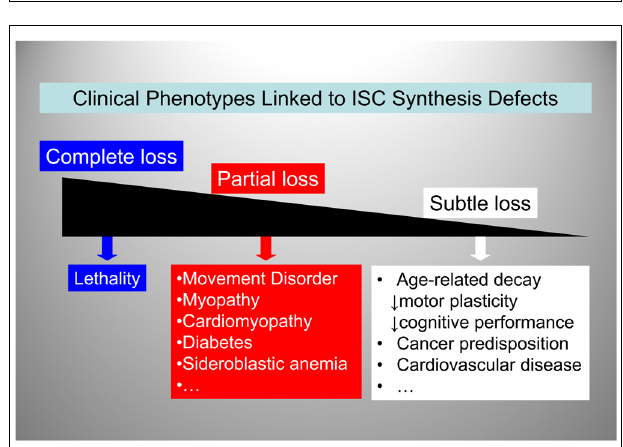
FIGURE 4 | Proposed model for a role of ISC synthesis defects in PD progression. See text for details.Tf, transferrin;TfR2, transferrin receptor; other abbreviations are as in the legend for Figure 3 .